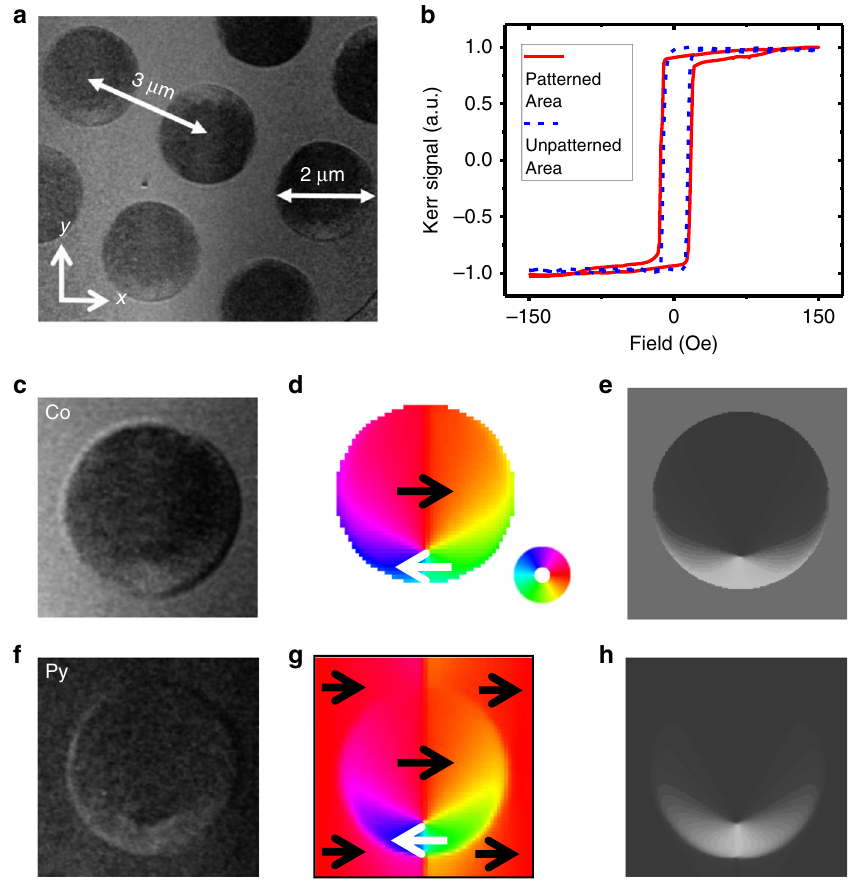
Fig. 2 Sample structure and vortex imprinting. a Sample geometry imaged by MTXM at Co L3 edge. b Hysteresis loops of the sample inside and outside the patterned area. c The in-plane magnetic contrast at Co edge at external fi eld of 50 Oe. d The corresponding simulated magnetization pro fi le in Co layer, with the color wheel shown next to it. e The x -component (horizontal) of magnetization in Co layer from simulation. f The in-plane magnetic contrast at Fe edge at external fi eld of 50 Oe. g The corresponding simulated magnetization pro fi le in Py layer. h The x -component (horizontal) of magnetization in Py layer from